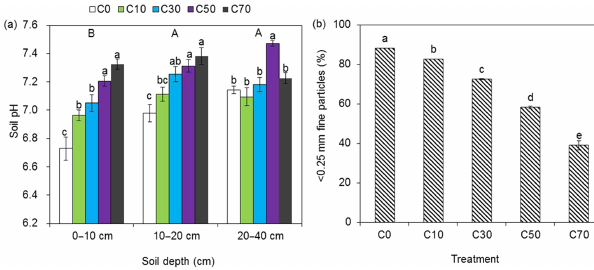
Figure 2. Soil pH values for three soil depths (a) and proportion of soil fine particles (<0.25mm) for 0–10cm soil in different soil coarseness degrees of 0% sand addition (C0), 10% (C10), 30% (C30), 50% (C50), and 70% (C70). Data represent mean ± SE ( n = 6). Letters indicate significant differences among treatments (lowercase letters) and differences among soil depths when averag- ing across all treatments (capital letters).